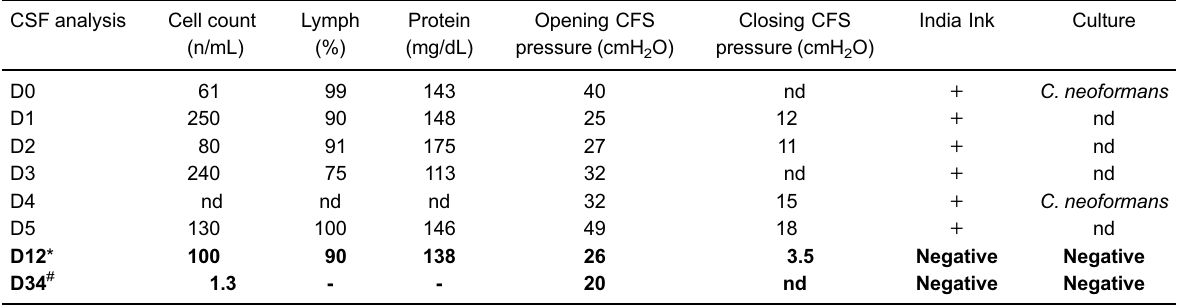
Table 1. Cerebrospinal fl uid (CSF) data of the patient from day zero (D0) until discharge from the hospital at day 34 (D34). CSF